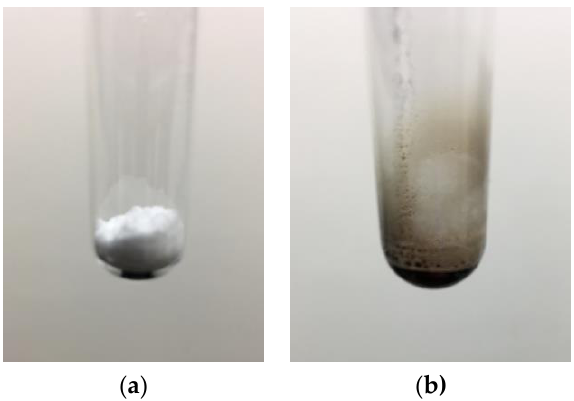
Figure 4. Image of acetaminophen before ( a ) and after heating with a hot air gun at 300 °C for 2 s ( b ). Clear evidence of thermal degradation is noted in panel ( b ).